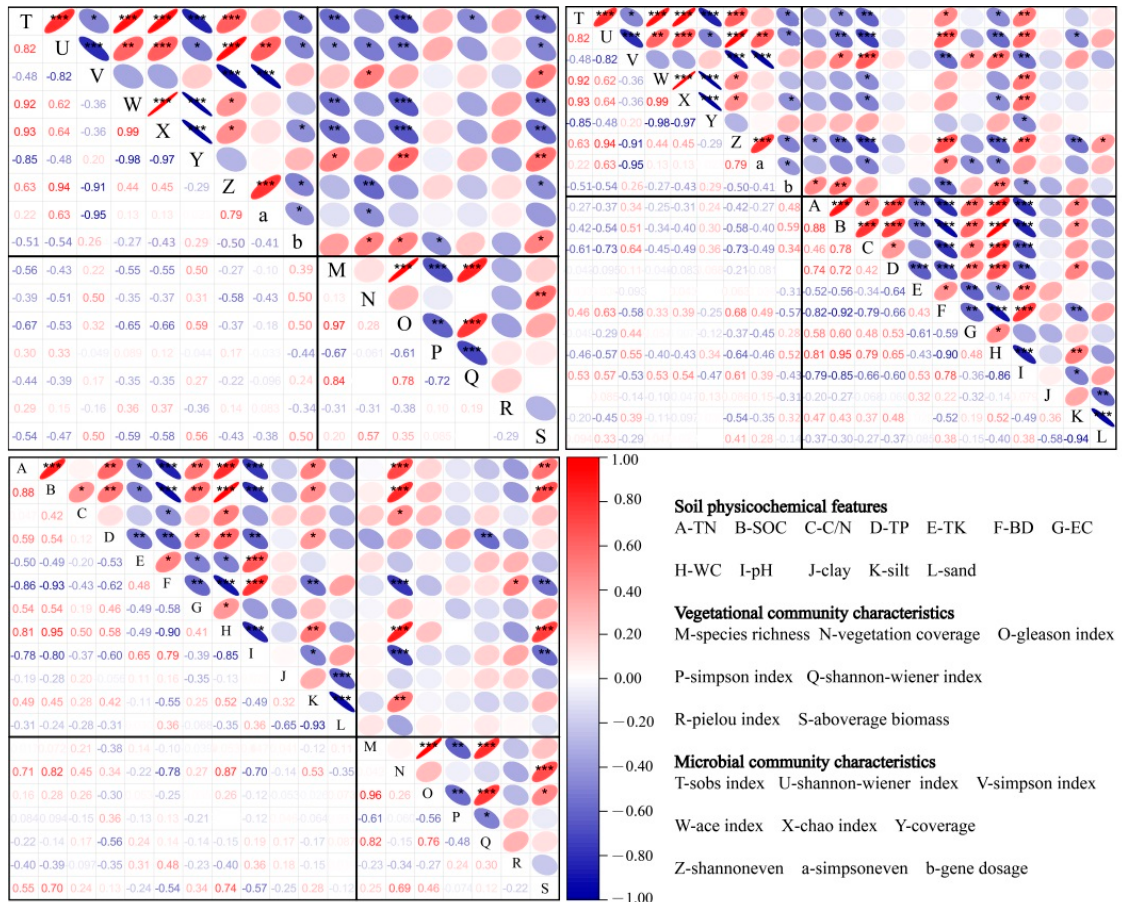
Figure 6. Correlation analysis among soil physicochemical features, vegetation community charac- teristics, and microbial community characteristics of the alpine meadow. *** p < 0.001; ** p < 0.01; * p < 0.05. IAM, intact alpine meadow; MDAM, moderately degraded alpine meadow; BSB, black soil beach; AAG, artificial grassland; EC, electrical conductivity; BD, bulk density; WC, water content; TOC, total organic carbon; TN, total nitrogen; TP, total phosphorus; TK, total potassium. The effects of the environmental variables on the microbial community are explained by a redundancy analysis (RDA) based on the phylum and genus level (Figure 7). At the phylum level, two coordinate axes explain 47.12% and 18.70% of the variation, respectively. Gleason and Simpson index of the vegetation community and TP are the key factors af- fecting the composition of bacterial communities significantly. At the genus level, two coordinate axes only represent 27.94% and 16.67% of the variation. Coverage and the Simpson index of the vegetation community and TN, TP, and pH in soils were significantly associated with bacterial communities. Furthermore, the partial Mental test was applied to explore the relationships between environmental matrixes and bacterial communities at the phylum and genus level (Table 3). Soil physicochemical features are significantly associated with bacterial community composition across all samples. In contrast, bacterial community distance is not significantly correlated with vegetation community character- istics, topographic factors, and the combination of vegetation community characteristics and topographic factors when soil physicochemical features are used as a control based